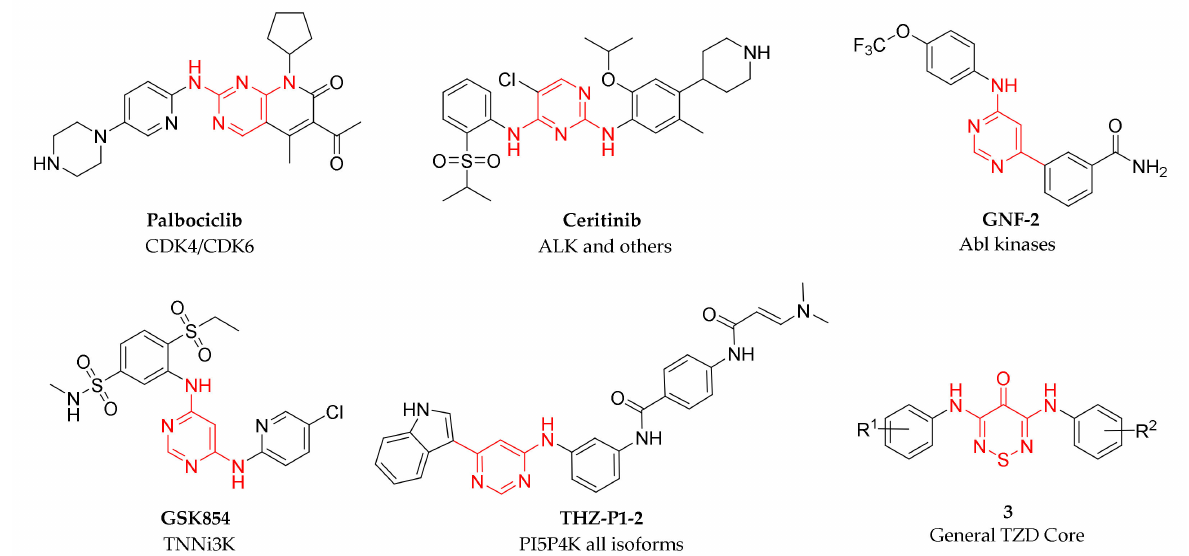
Figure 1. Representative examples of known anilinopyrimidines (highlighted in red) and general 1,2,6-thiadiazinone core ( 3